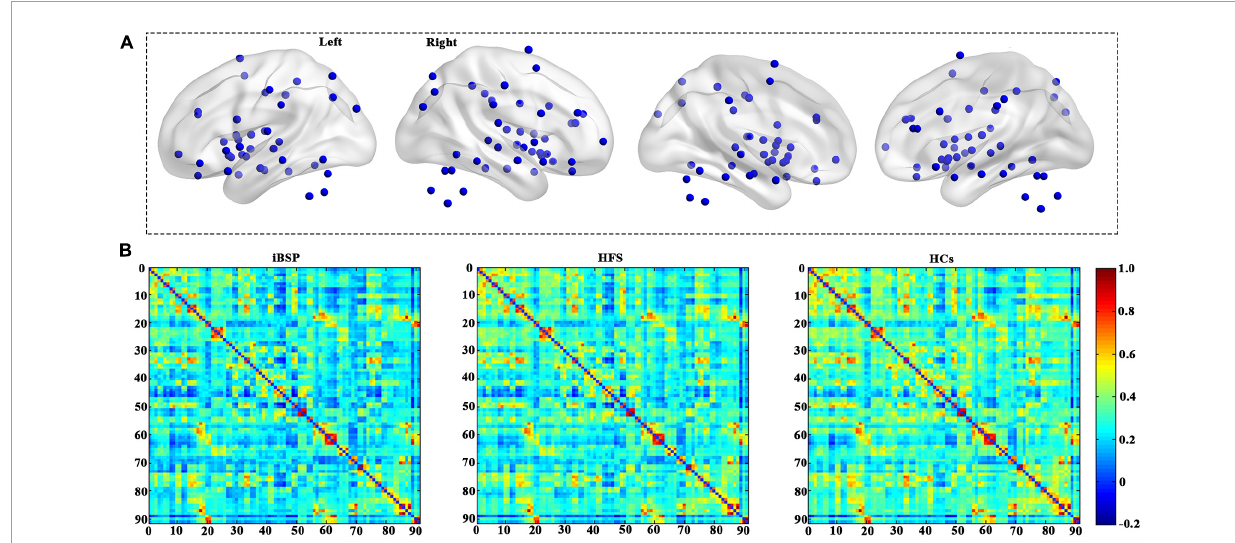
FIGURE1 Cortico-basal ganglia networks. (A) Distributions of all brain regions in the cortico-basal ganglia networks. All regions are listed in Supplementary Table 1 . (B) The average functional connectivity matrix of the cortico-basal ganglia networks for patients with idiopathic blepharospasm and hemifacial spasm and HCs. HCs, healthy controls; HFS, hemifacial spasm; iBSP, idiopathic